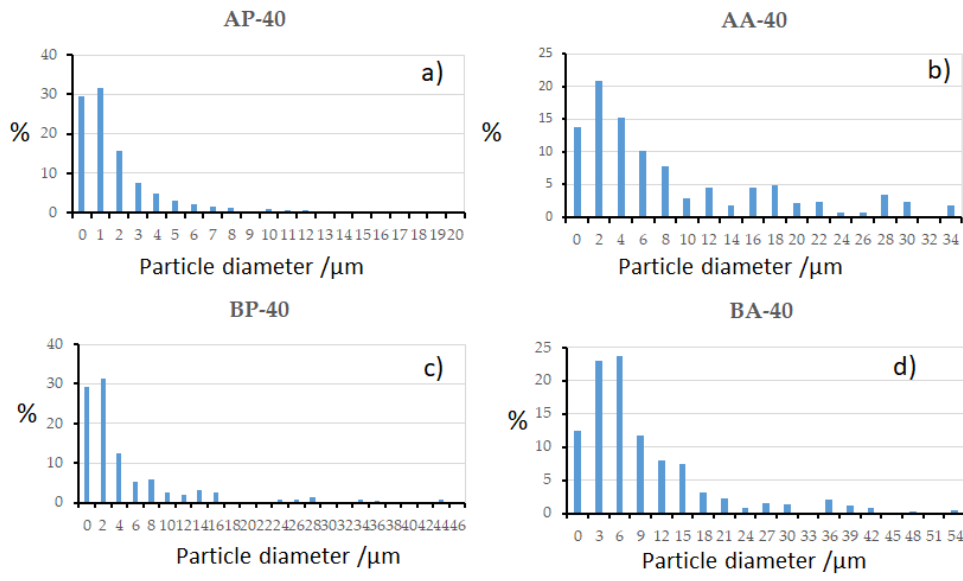
Figure 2. Particle size distribution of: ( a ) AP-40, ( b ) AA-40, ( c ) BP-40, and ( d ) BA-40.